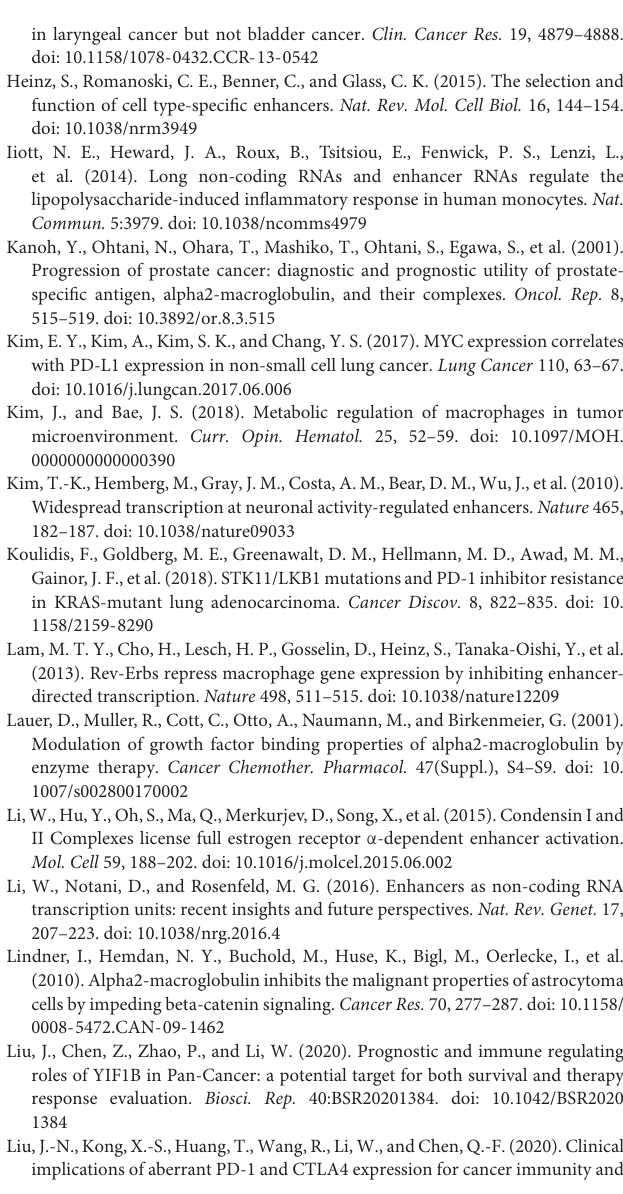
Supplementary Figure 1 | Analysis of the functional characteristics of LINC00987/A2M. Correlation of the expression of (A) LINC00987 and (B) A2M with hypoxia gene sets. Correlation of the expression of (C) LINC00987 and (D) A2M with tumor stem cell characteristics. * p < 0.05, *** p < 0.01, *** p < 0.001, and **** p < 0.0001. Supplementary Figure 2 | Landscape of somatic mutation of LINC00987/A2M axis in TCGA. Top 20 genes in LINC00987 (A) high and (B) low expression group, A2M (C) high and (D) low expression group, respectively. Supplementary Figure 3 | Function enrichment analysis of LINC00987/A2M axis in GSEA. Kyoto Encyclopedia of Genes and Genomes (KEGG) for high and low expression groups of (A) LINC00987 and (B) A2M; Gene Ontology (GO) term of Biological Process (BP) for high and low expression groups of (C) LINC00987 and (D) A2M; cellular component (CC) for high and low expression groups of (E) LINC00987 and (F) A2M; molecular function (MF) for high and low expression groups of (G) LINC00987 and (H)